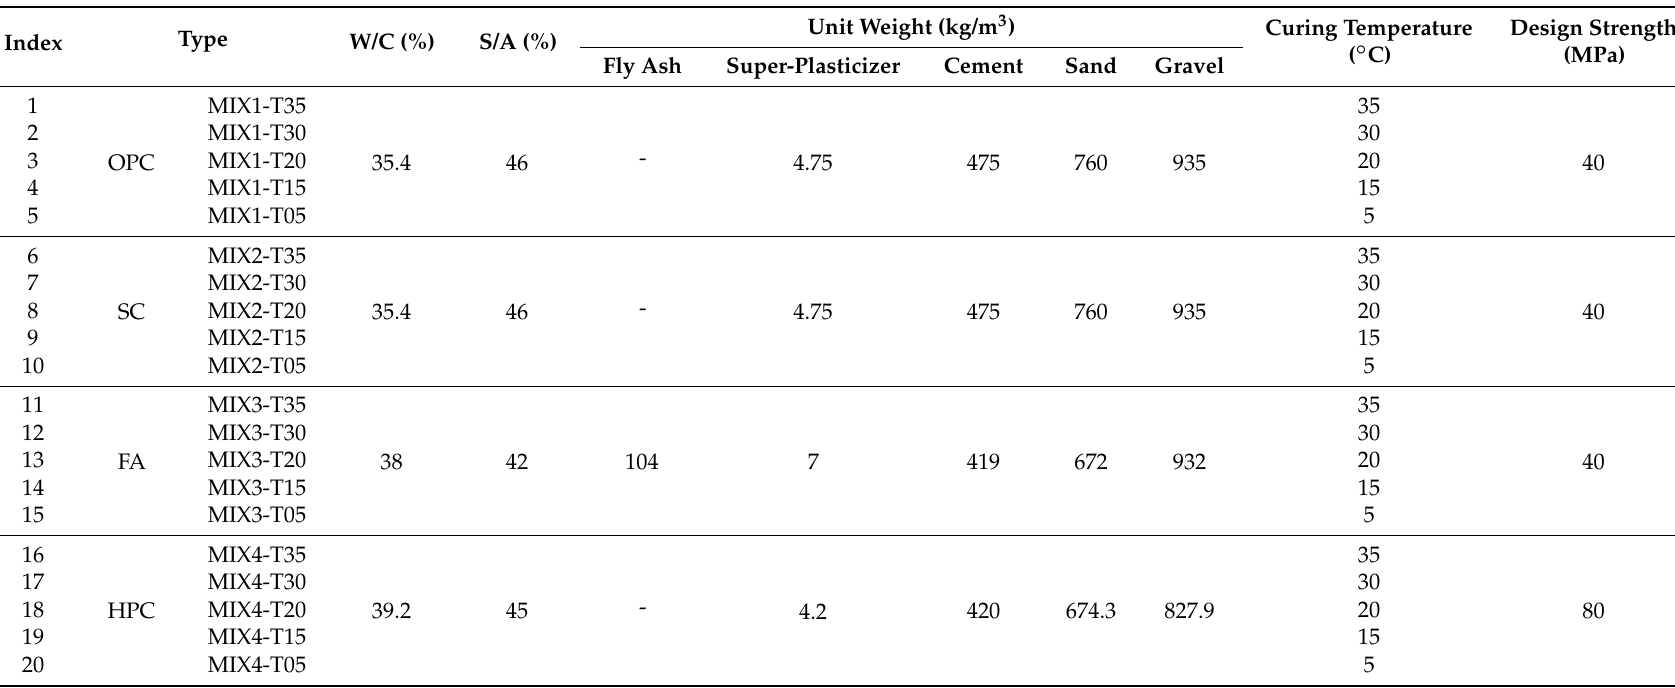
Table 2. Mixture proportions per cubic meter for the surface wave velocity measurement, cylindrical compressive strength test, and penetration resistance